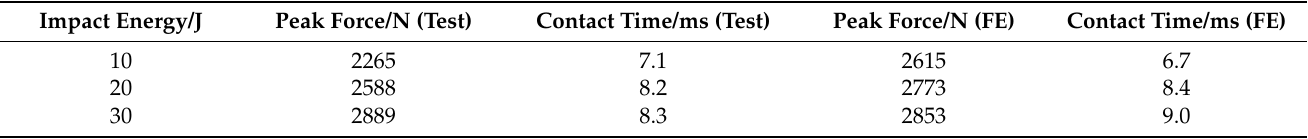
Table 3. Contact force and time of test and